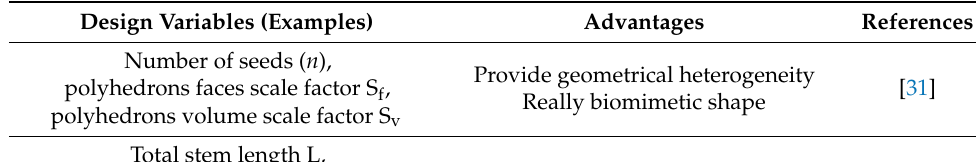
Table 2. Comparison of design